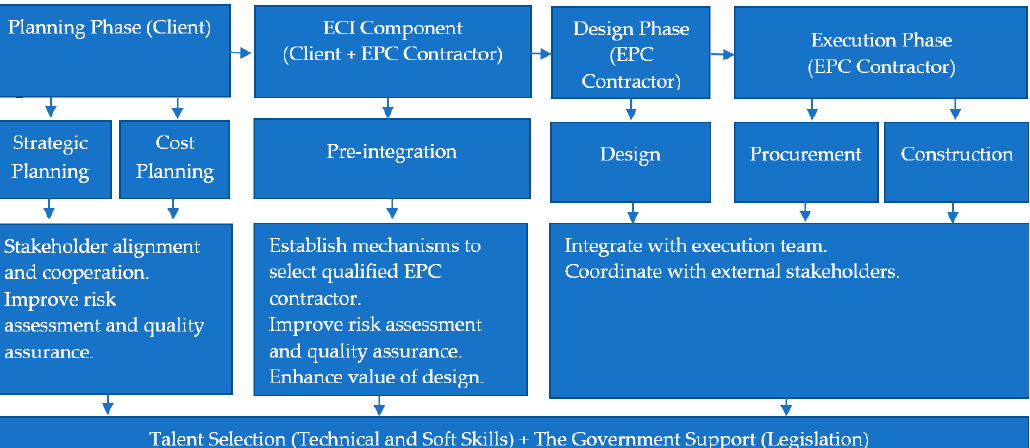
Figure 5. Recommendations for design change management.